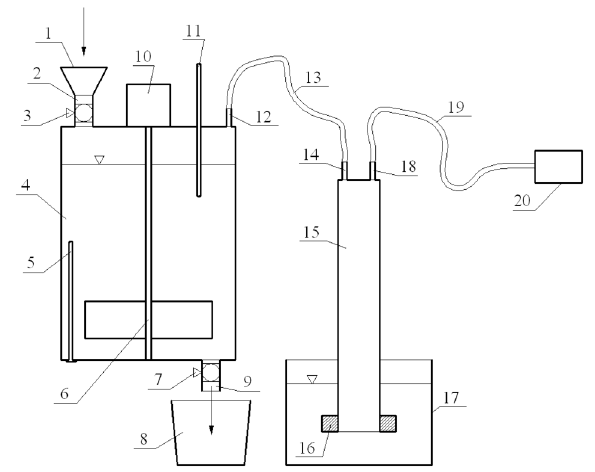
Fig. 4. Scheme of laboratory bioreactor